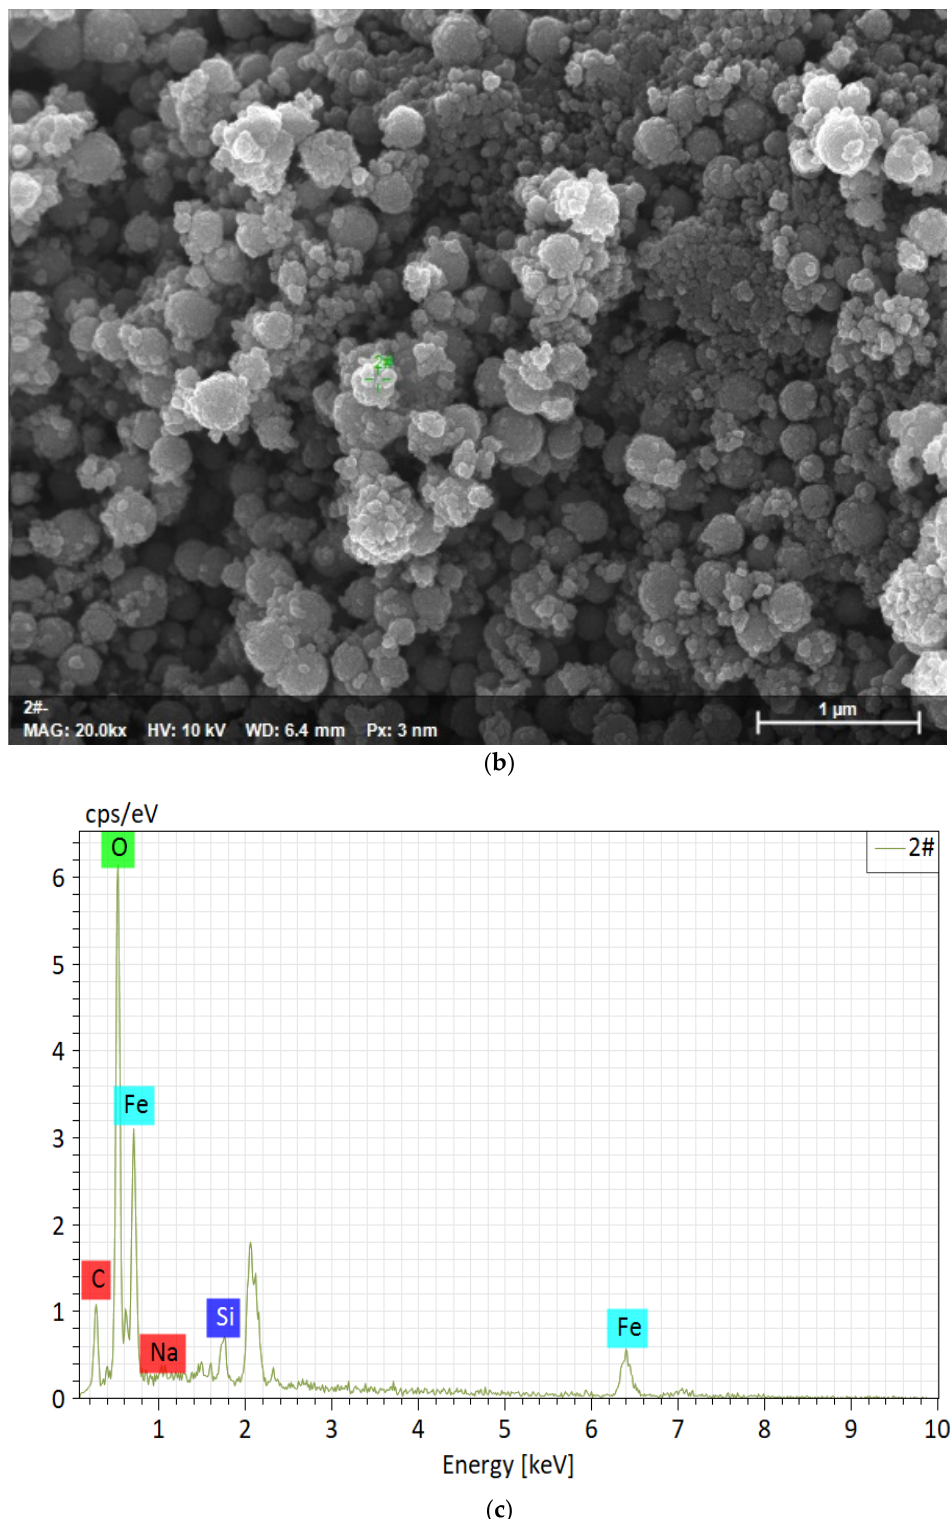
Figure 2. SEM images of N-Zeo ( a ), M-Zeo ( b ), and EDS of M-Zeo ( c ). The BET-specific surface area, pore volume, and pore size are templated in Table 1. M-Zeo had better BET-specific surface area and pore volume than N-Zeo. The increase in BET of M-Zeo was attributed to the nanoscale of magnetite occupied on the surface of zeolite. The adsorption curves of both N-Zeo and M-Zeo showed a shape of IV isotherm